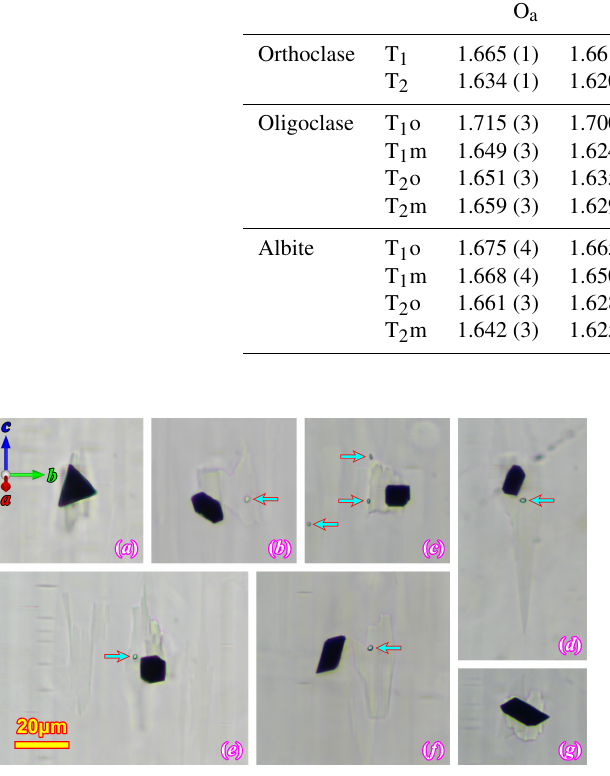
Figure 6. Magnetite seeds in (100) thin sections under optical mi- croscope. All the images are taken under plane polarized light. Pan- els (c) , (d) and (e) are focus-stacked to bring both the magnetite crystal and the associated albite lamellae into focus. The arrows mark an unidentified phase that is commonly associated with the magnetite seed and oligoclase